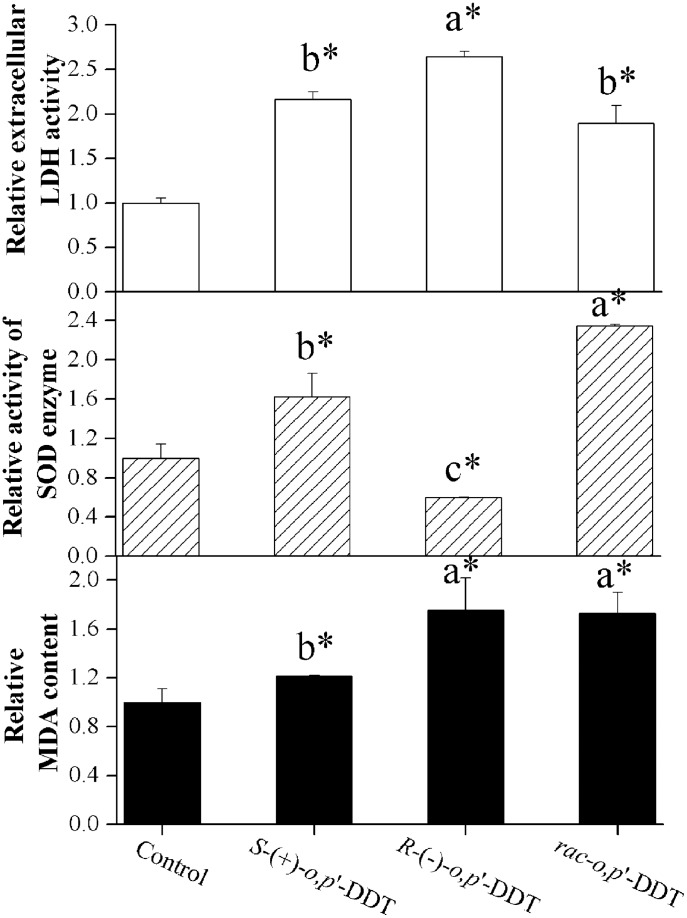
Oxidative stress induced by racemate and enantiomers of o,p’-DDT.Effect of the racemate of o,p’-DDT and individual stereoisomers on extracellular lactate dehydrogenase (LDH) release, intracellular superoxide dismutase (SOD) and malondialdehyde (MDA) production at concentration of 3.5×10−5 mol/L. Data are presented as the relative value of control. PC12 cells were exposed to different compounds for 24 h. The asterisk above each bar indicates a significant difference compared to a negative control (p<0.05, n = 3). Different letters above adjacent bars indicate a significant difference (p<0.05) between the two enantiomers, whereas the same letter indicates no significant difference.